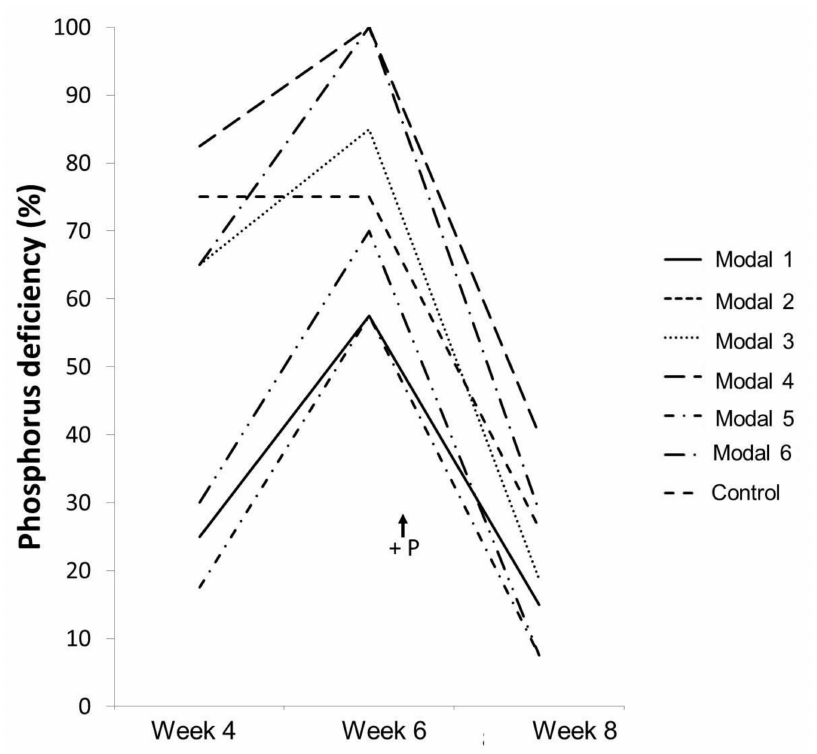
Figure 12. Temporal evolution of the percentage of phosphorus deficiency (purple leaves) in plants from 4 weeks after planting up to 6 and 8 weeks only considering applied treatments. Modality 1 = AMF (strain IP21); modality 2 = AMF (strain IP21) + Trichoderma harzianum ; modality 3 = AMF (strain IP21) + Pseudomonas fluorescens (strain IPB04); modality 4 = AMF (strain IP21) + Trichoderma harzianum + Pseudomonas fluorescens (strain IPB04); modality 5 = commercial AMF product containing 6 AMF strains; modality 6 = commercial AMF product containing 6 AMF strains + Trichoderma harzianum.